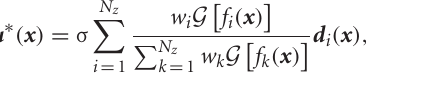
FIGURE 1 | Swing-up pole